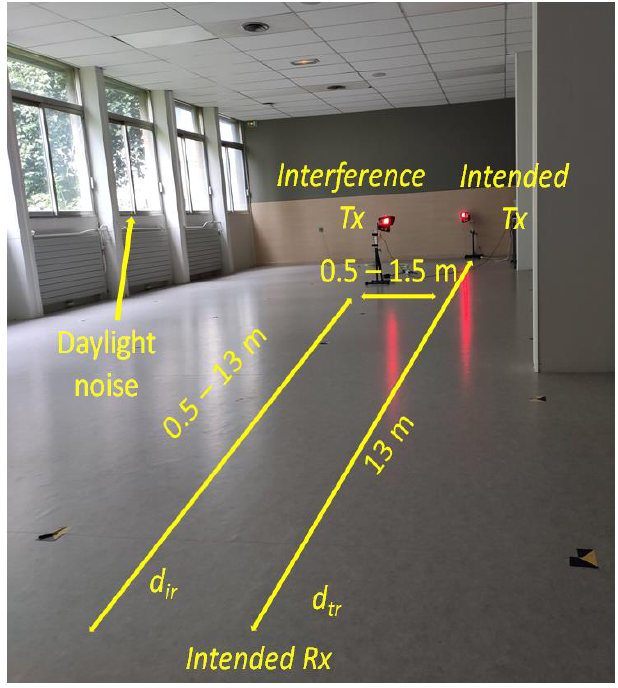
Figure 12. Experimental multi-user interference testing setup: VLC transmitter and VLC receiver are aligned and maintained at constant distance, whereas the interference VLC transmitter position with respect to the V2V link changes in both longitudinal and lateral distances.